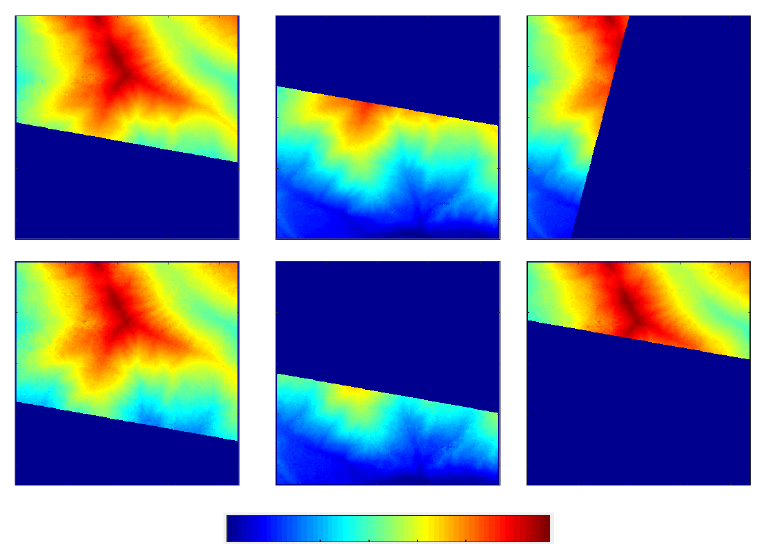
Figure 15. Results of pairwise SGM applied over multiple images covering stable terrain area of Figure 14. Only six image pairs are shown here. The total combinations of overlapping image pairs is greater than 30 for this area. The elevation values are color coded with red representing higher elevation.